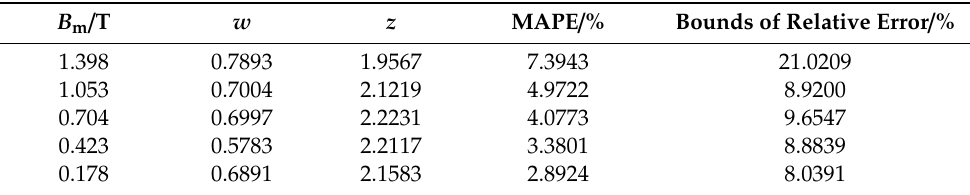
Figure 10. Variation of mean absolute percent error (MAPE) with number of iterations based on the PSO algorithm at 1.398T.